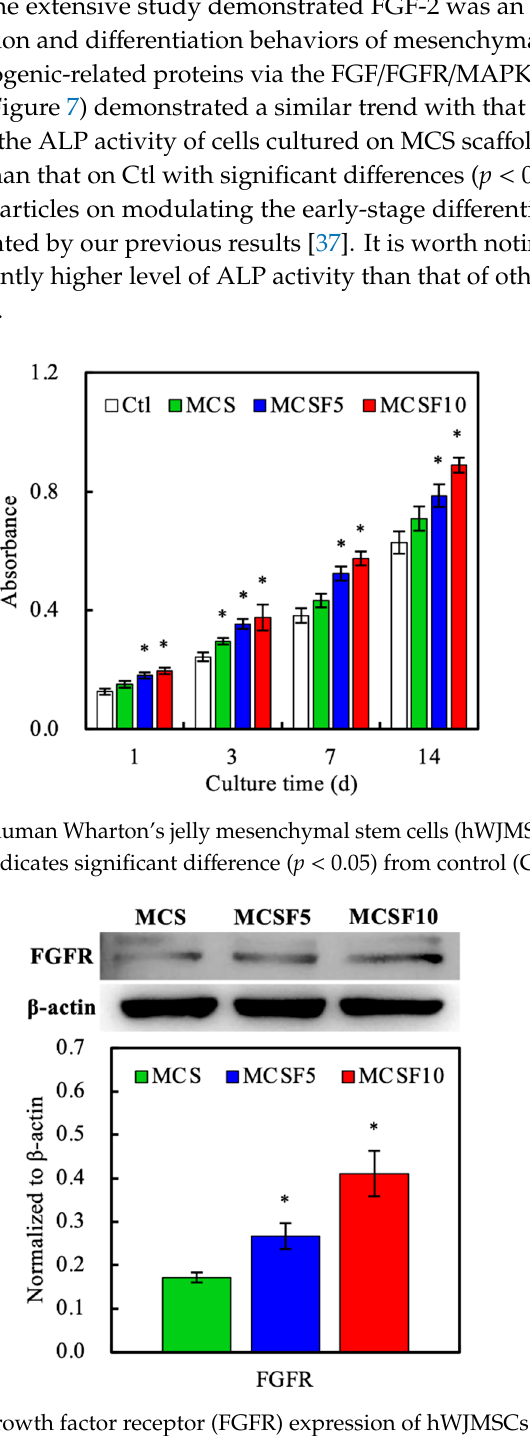
Figure 6. The fibroblast growth factor receptor (FGFR) expression of hWJMSCs cultured on different scaffolds. * indicates significant difference (p < 0.05) from MCS group.